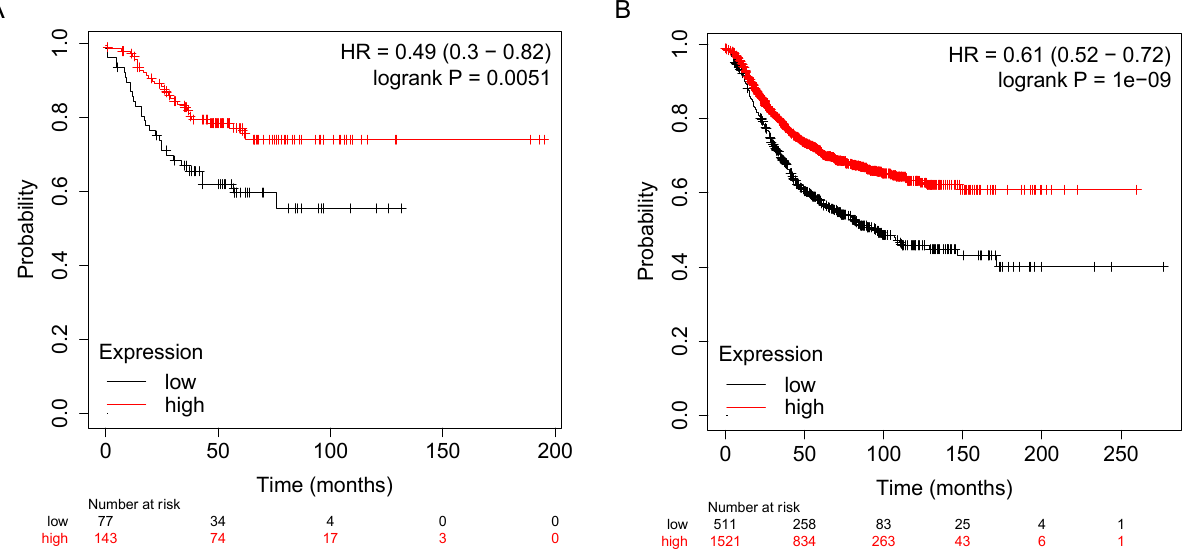
Figure 3. Macrophage gene signature induced by FEC + oHSV-1 therapy correlates with improved clinical outcomes. ( A ) Kaplan–Meier survival plot for TNBC patient RFS ( n = 220) microarray data based on mean mRNA expression level of the wight macrophage-associated genes in Table 1. ( B ) Kaplan–Meier survival plot for all BC patient RFS ( n = 2032) and microarray data based on mean mRNA expression level of the eight macrophage-associated genes in Table 1.